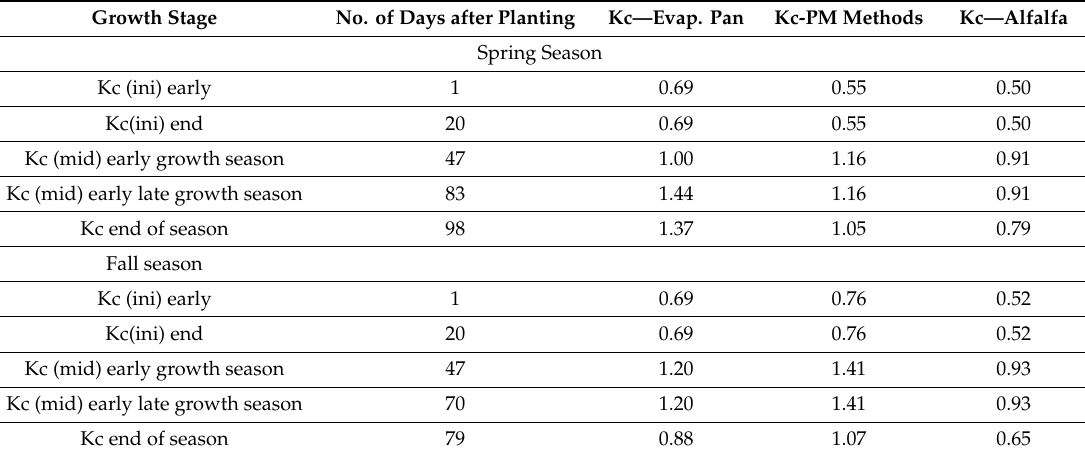
Table 4. Mean Kc for the main growth stages during the spring and fall seasons taking the alfalfa as a reference for comparison.